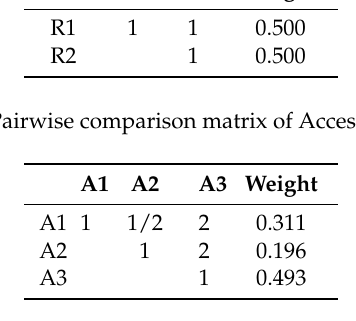
Table A3. Pairwise comparison matrix of Capacity indicators.